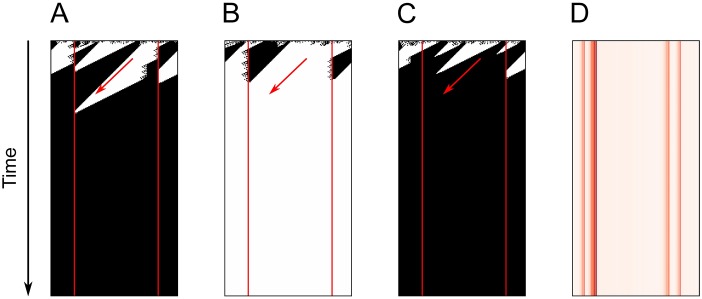
Space-time diagram of executions of the best cellular automaton found with p = 0.01 rewired connections, for three different initial configurations.In (A), (B) and (C), limits and flow directions are indicated, respectively, by the vertical lines and diagonal arrows. In (D), darker colors indicate that a cell acted more frequently as a limit.